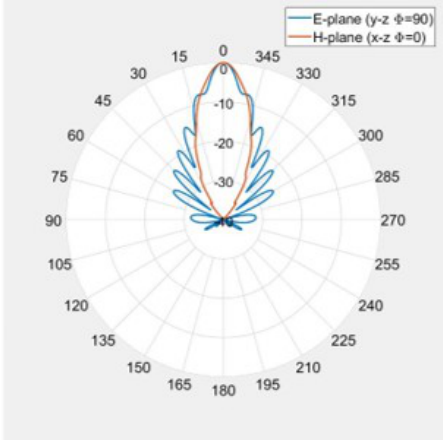
Figure 6. Millimeter wave horn antenna radiation